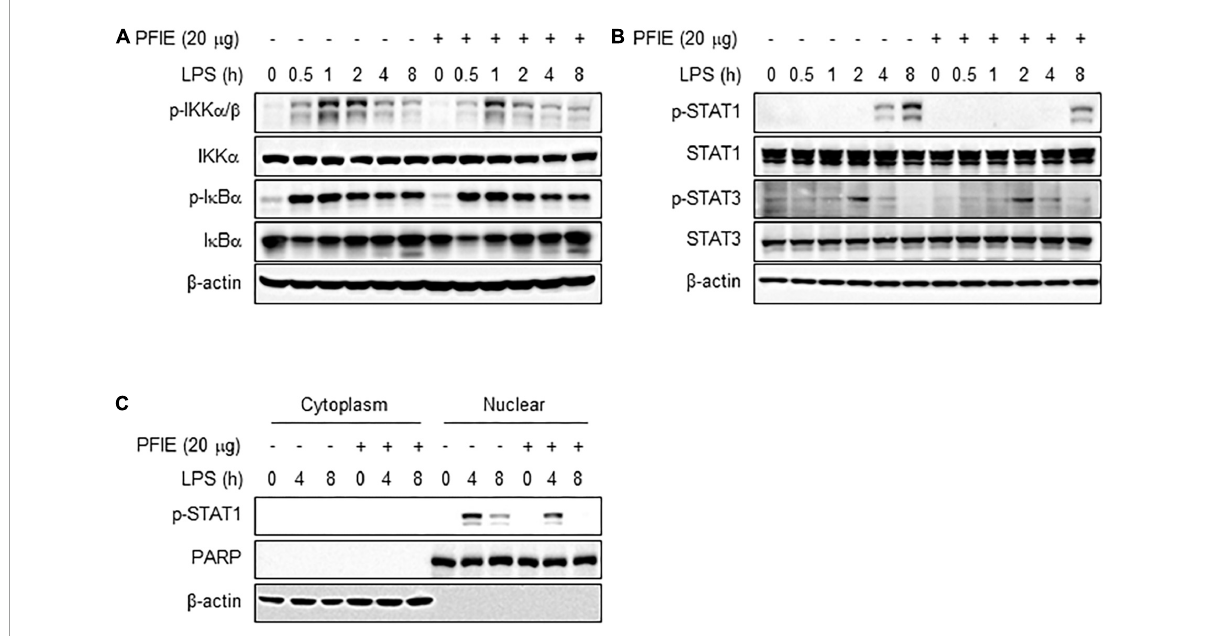
FIGURE3 PFIE inhibits LPS-induced STAT1 activation in J774 macrophages. (A) IKK α / β and I κ B α and (B) STAT1 and STAT2 phosphorylation in LPS-stimulated J774 cells in the presence or absence of PFIE was examined using immunoblotting. (C) pSTAT1 in the cytosol and nuclear fraction was examined using immunoblotting. PARP and β -actin were used as a nuclear and cytosolic fraction loading control,